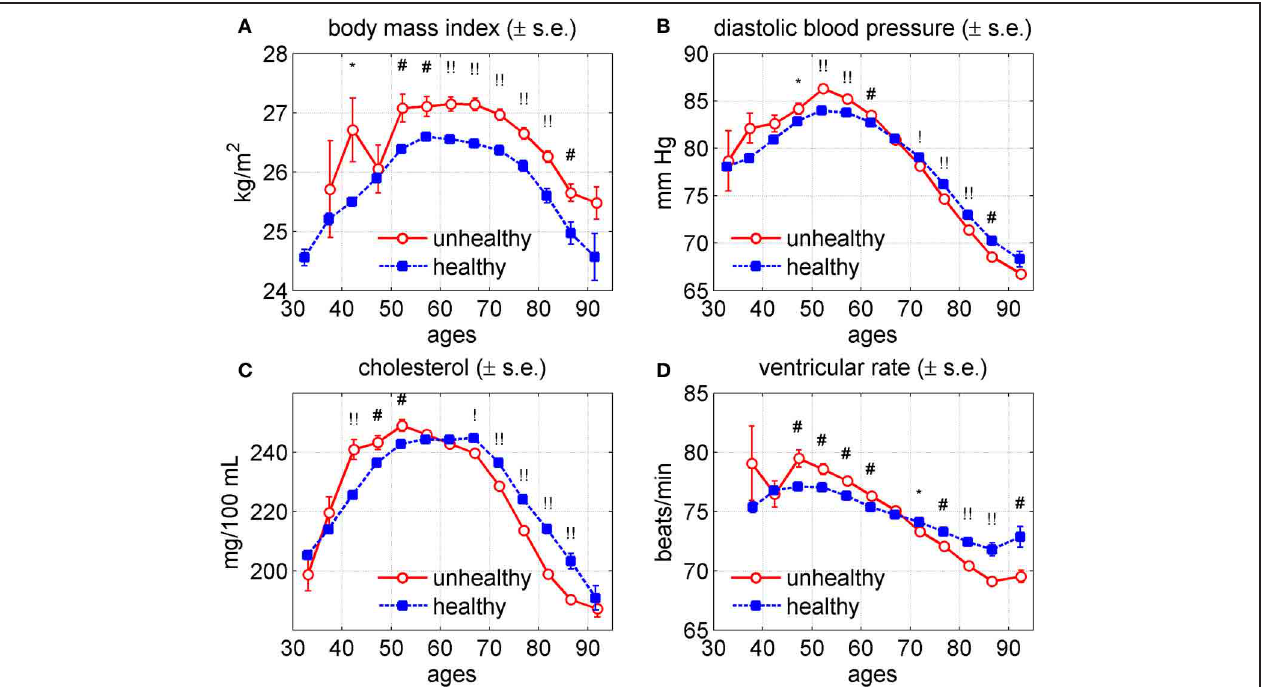
physiological indices before the onset of any of these diseases contribute to the “healthy” trajectory and those after the onset of any of the diseases contribute to the “unhealthy” trajectory. Symbols above the curves correspond to p -values for testing the null hypotheses on equality of means in respective age groups: no symbol: p ≥ 0 . 05; ∗ : 0 . 01 ≤ p < 0 . 05; # : 0 . 001 ≤ p < 0 . 01; ! : 0 . 0001 ≤ p < 0 . 001; !! : p < 0 .